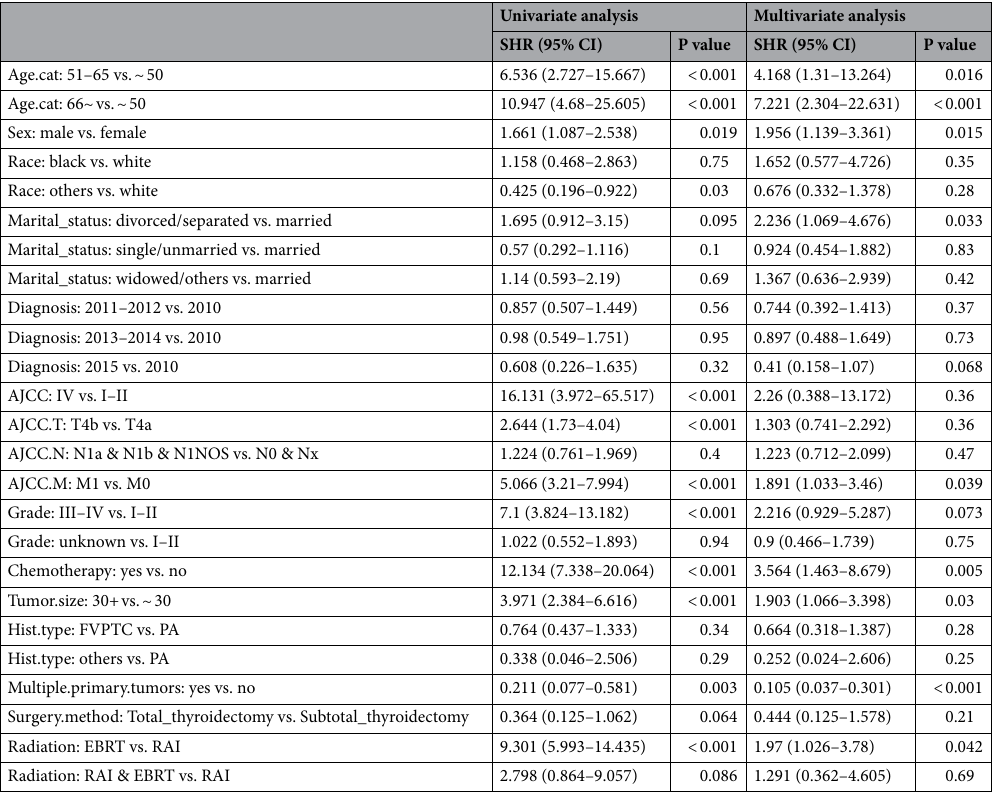
Table 4. Univariate and multivariate analyses of the competitive risk model under three